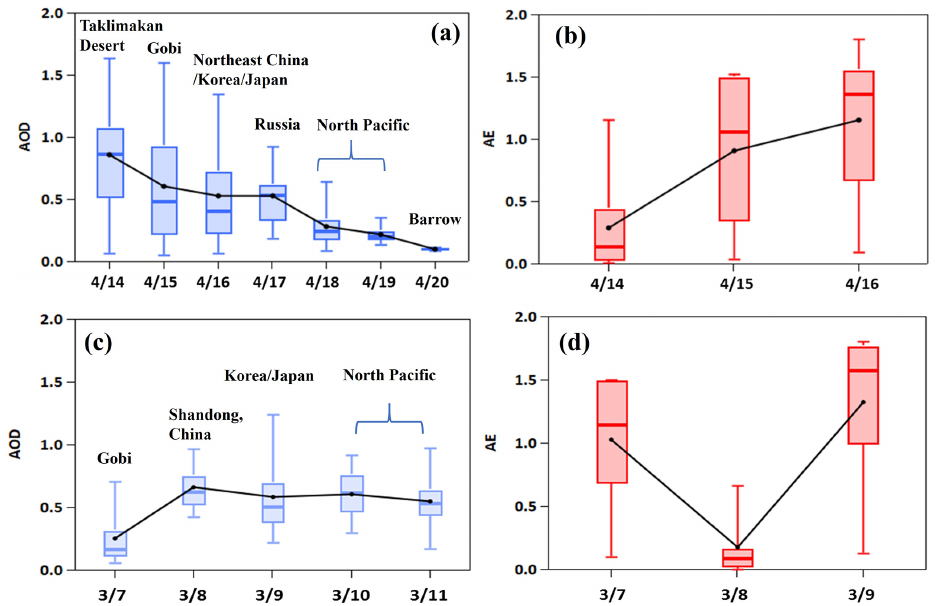
Figure 10. Regional (a) AOD and (b) Angström exponent in CASE I. Regional (c) AOD and (d) Angström exponent in CASE II. The dots and lines inside the boxes represent the mean and median values, respectively; bottom and top of the boxes represent the 25% and 75% limits, respectively; and bottom and top short lines represent the minimum and maximum values, respectively. The geographic region in each day is defined in Fig. S1 in the